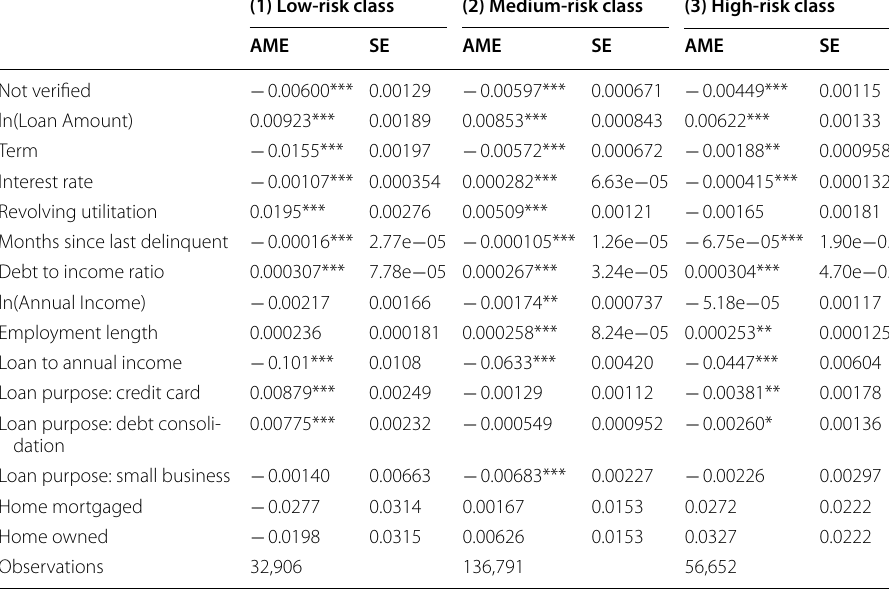
Table 11 Average marginal